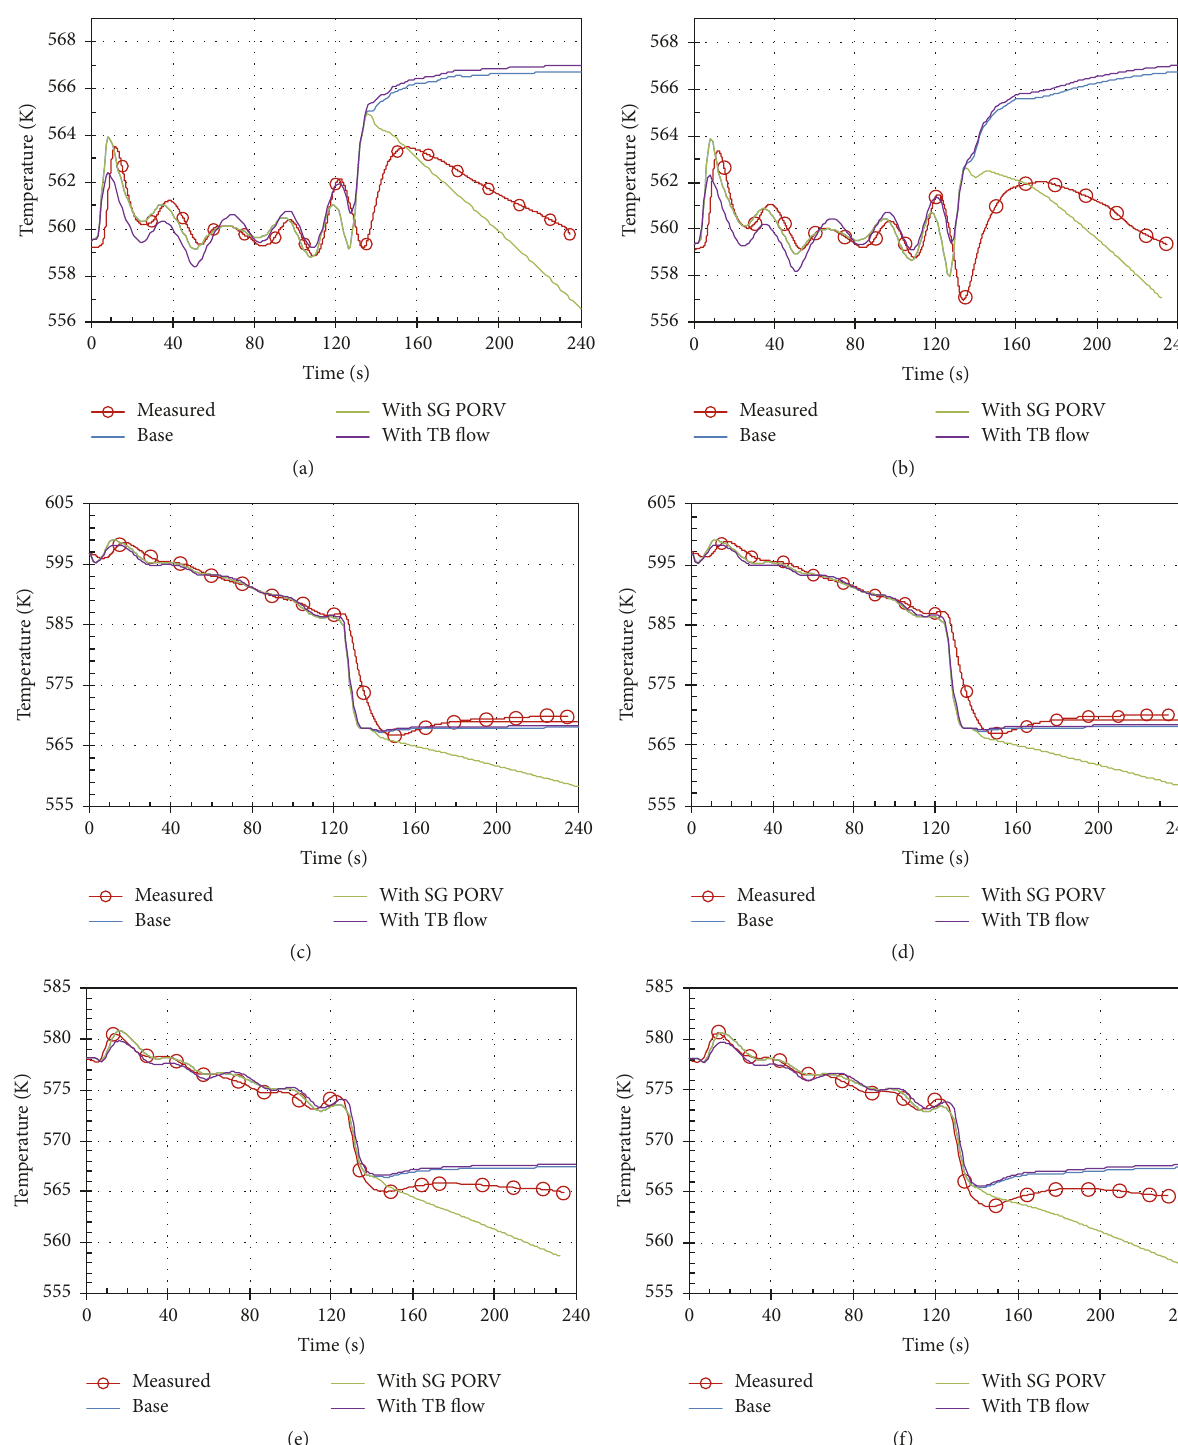
Figure 12: Second part: (a) cold leg number 1 temperature; (b) cold leg number 2 temperature; (c) hot leg number 1 temperature; (d) hot leg number 2 temperature; (e) RCS loop number 1 average temperature; (f) RCS loop number 2 average